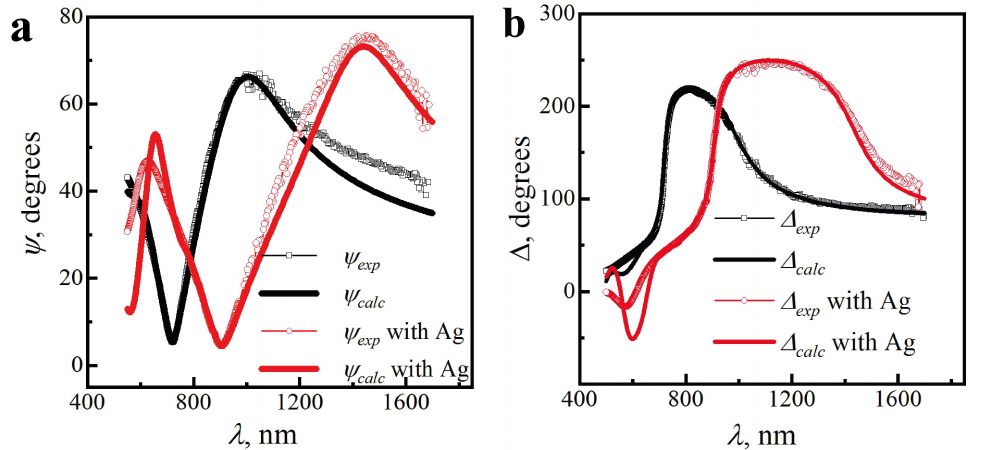
Figure 7. Experimental ( exp ) and calculated ( calc ) ellipsometric spectra ( a ) ψ ( λ ) and ( b ) ∆ ( λ ) of SiNWs before (black) and after (red) AgNP deposition for sample